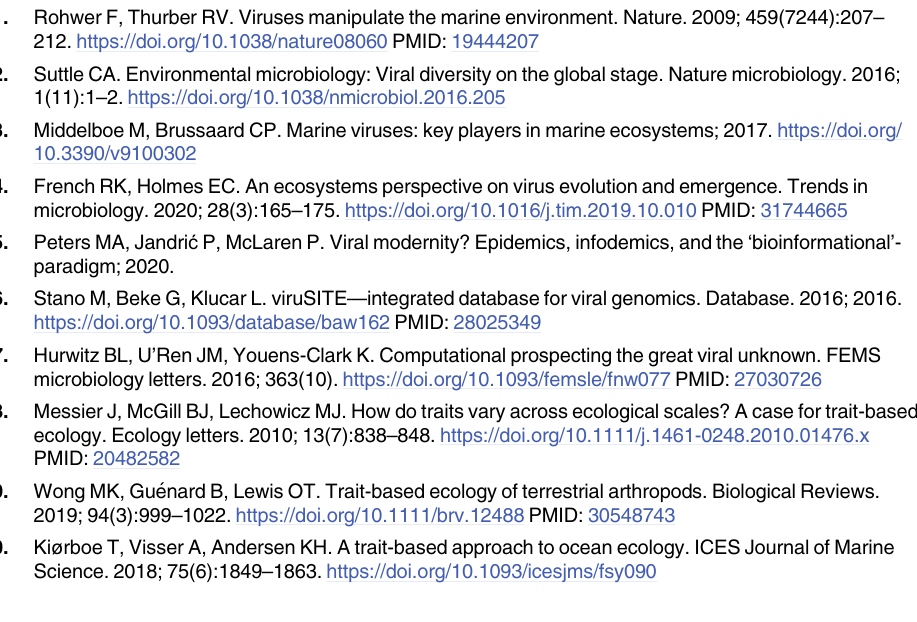
S2 Fig. Evolutionary diversification of host and virus genotypes. Diversity time-series based on Shannon entropy of ensemble averages from 100 runs in a trade-off based compatibiltiy and virulence scenario shown for a) nutrient affinity of host ( g ), b) adsorption coefficient of α virus ( g ), and c) memory gene of virus ( g ). Small subpanels show abundance distribution for β ν the genotypes at three distinct time points over the course of T = 720 h.